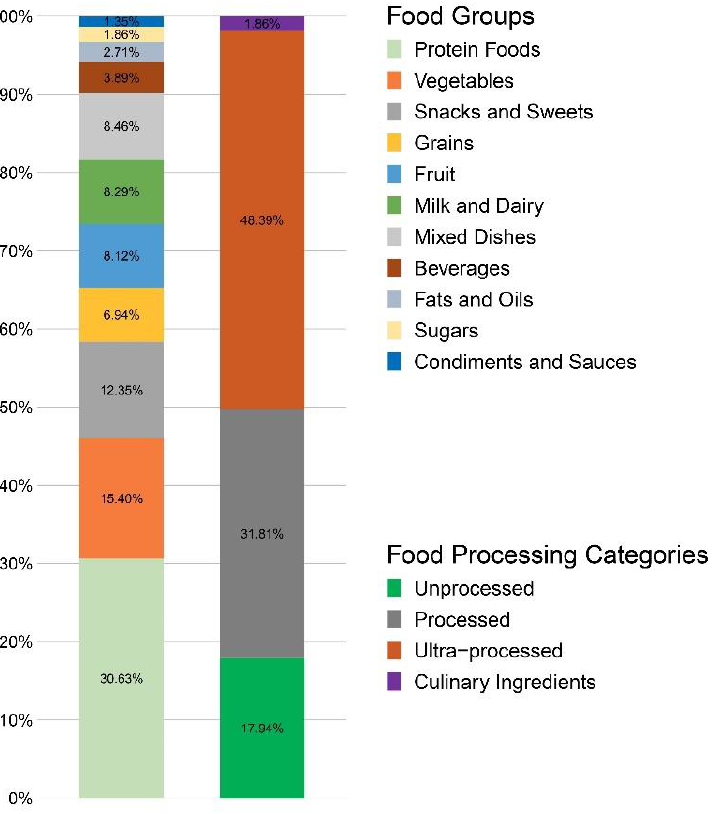
Figure 1. Distribution of foods by food group and NOVA classification system.